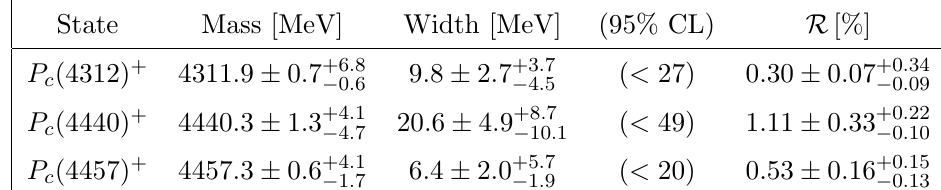
Table 1 . Masses, decay widths (with 95% C.L. upper limits), and the ratio R , of the three narrow J= p resonances observed by the LHCb collaboration in the (cid:3) b ! J= p K (cid:0) decay [1]. expected to be small in the hadron-molecule interpretation. It is relevant to point out that model-dependent 90% C.L. upper limits on B ( P + ! J= p ) of 4.6%, 2.3%, and 3.8% c for P + (4312), P + (4440), and P + (4457), respectively, have been posted by the c c c